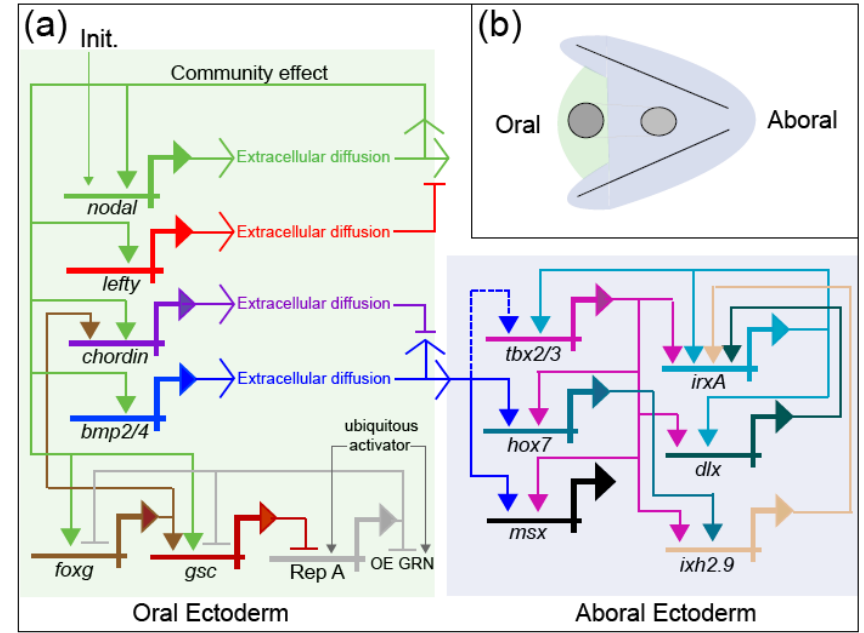
Figure 3. A model of the gene regulatory network (GRN) underlying differentiation of oral and aboral ectoderm in the sea urchin embryo [33,34]. (a) Map of the GRN, wherein the cis -regulatory domains of genes are represented by thick horizontal lines terminating in bent arrows, which represent the expressed structural information (ultimately proteins) encoded by the gene. Positive (activating) regulatory inputs are represented by arrows impinging on genes, whereas negative (repressive) regulatory inputs and other inhibitory interactions are represented by bars. Chevrons denote emission and receipt of extracellular signals. The network was mapped by perturbation analyses in which the expression of individual genes was specifically inhibited, and the quantitative and/or spatial effects on all the other genes in the network subsequently measured at specific developmental time-points [33,34]. The network architecture represents historical information that determines how (1) the localized community effect entrained by the nodal / lefty feedback circuit (see Figure 1) becomes an ‘organizing center’ that specifies presumptive oral and aboral territories (‘regulatory states’ [31], indicated by the colored shading), by coupling extracellular Nodal signaling, which is localized by long-range Lefty-mediated inhibition, to extracellular BMP2/4-signaling, which is long-range by virtue of localized Chordin-mediated inhibition; (2) genes in the oral ectoderm network (OE GRN) are later activated, involving a “double-negative” gate in which activation of the OE GRN requires the gsc -mediated repression of a repressor (as-yet unidentified RepA) of those genes [33]; and (3) specification of aboral ectoderm (via BMP2/4 signaling) rapidly leads to a rigidly determined state via the mutually reinforcing interactions of several transcription factors [33]. The dashed blue line impinging on tbx2/3 indicates that there is conflicting evidence regarding this input [33,34,34]. (b) Color-coded map relating the GRN and regulatory states shown in (a) to the body plan of the